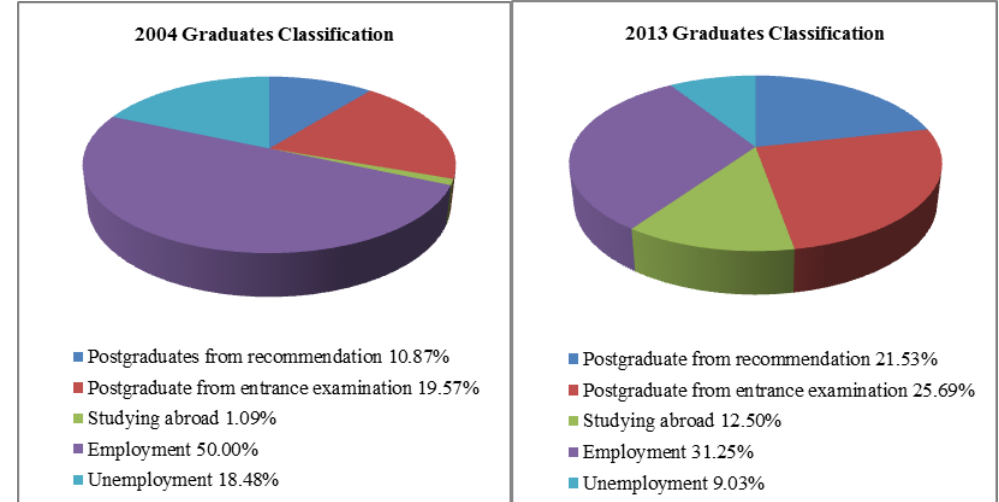
Figure 4. 2004/2013 Classification of Graduates with Bachelor’s